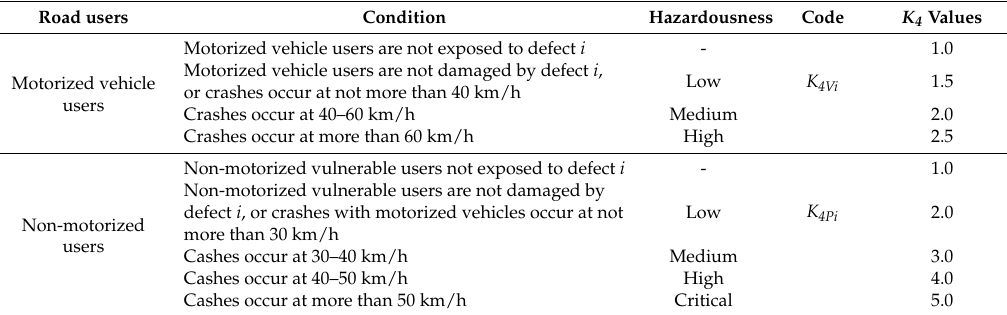
Table 5. Values of the hazardousness factor K 4i .